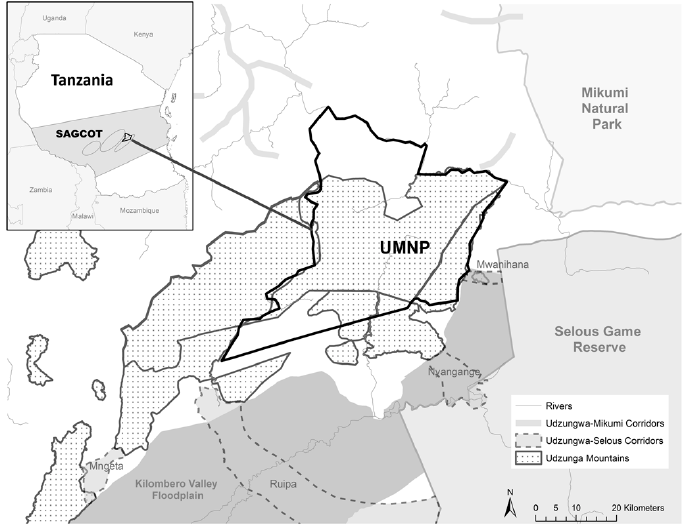
Figure 1. Udzungwa Mountains National Park (UMNP), Protected Areas (PAs) around and wildlife corridors connecting to the UMNP. Insert: Location of the UMNP within the Development Clusters (shown as ellipse) in the SAGCOT area in Tanzania. The Kilombero cluster is the most southern ellipse.